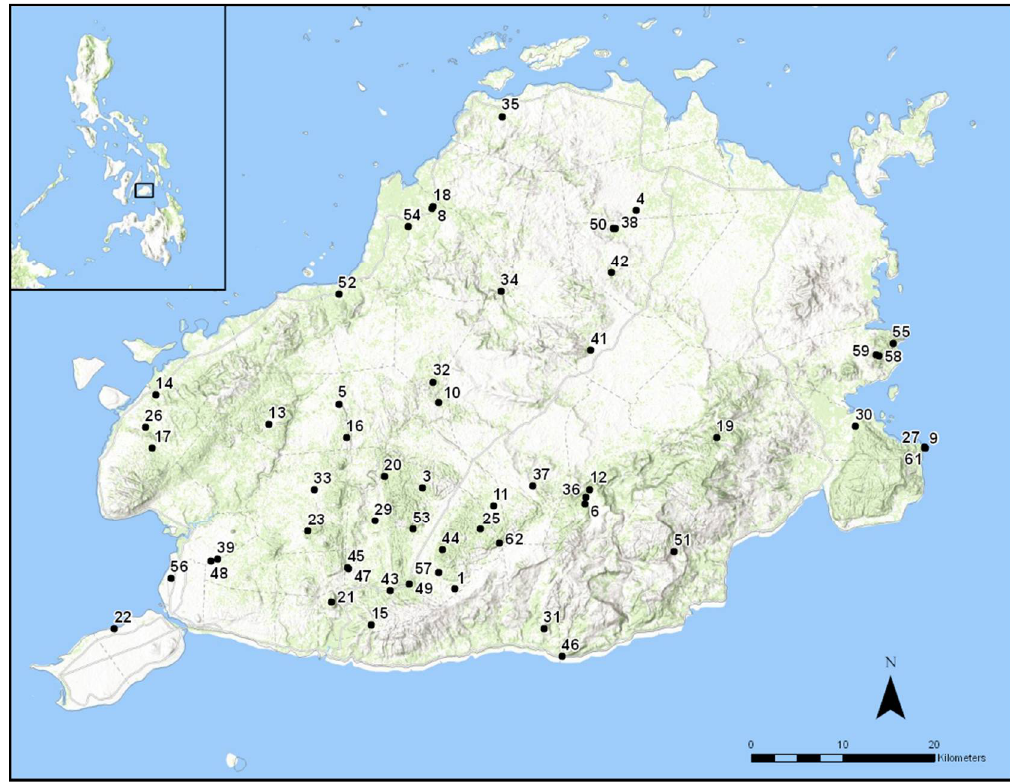
Figure 1. Caves ( n = 56) surveyed on Bohol Island, the Philippines (see insert). Map created using the World Topographic basemap in ArcGIS ® software by Esri. See Table S1 for additional information about each cave.